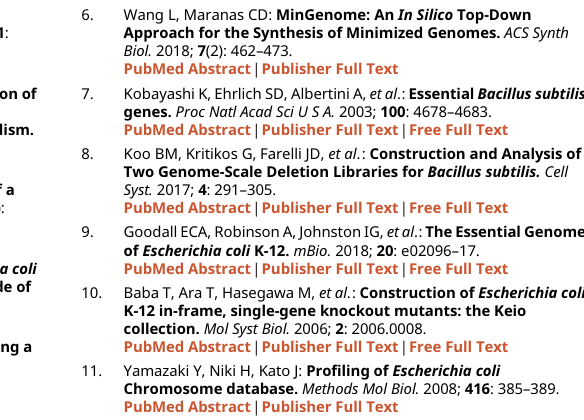
Figshare: Underlying data for ‘ A pan-genome method to determine core regions of the Bacillus subtilis and Escherichia coli genomes ’ , https://doi.org/10.6084/m9.figshare.15129636.v1. 58